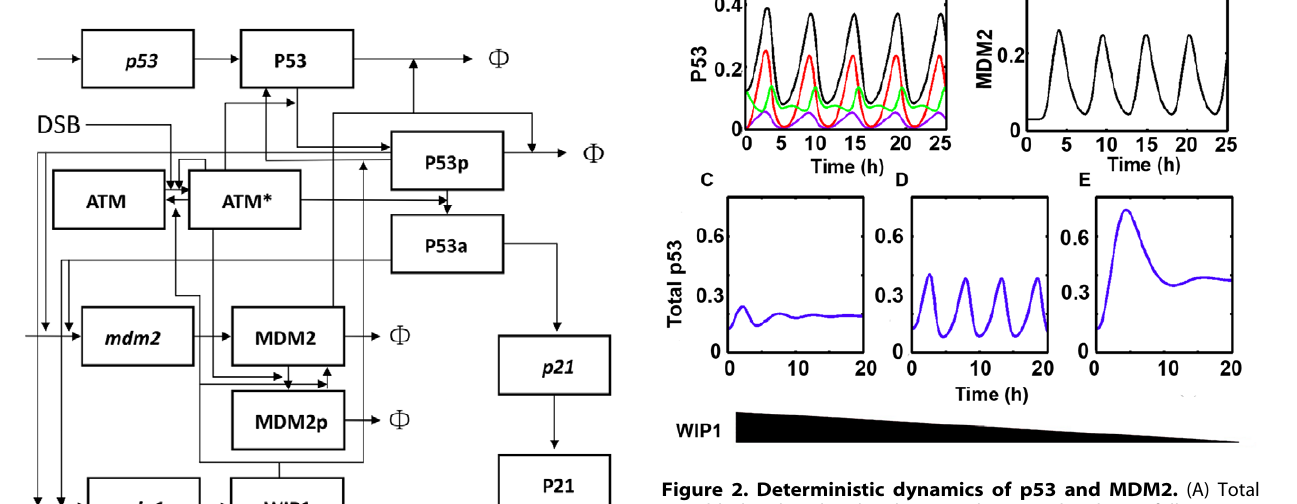
Figure 2. Deterministic dynamics of p53 and MDM2. (A) Total p53 (black), phosphorylated p53 (violet), acetylated p53 (fully compe- tent form, red), unmodified p53 (green). (B) MDM2 pulses. (C–E) p53 dynamics with different WIP1 levels. WIP1 levels decrease from left to right (C: overexpression, s wip1 :0.0045 and e 2 :0.05. D: nominal E: reduced expression, s wip1 :0.001 and e 2 :0.001).